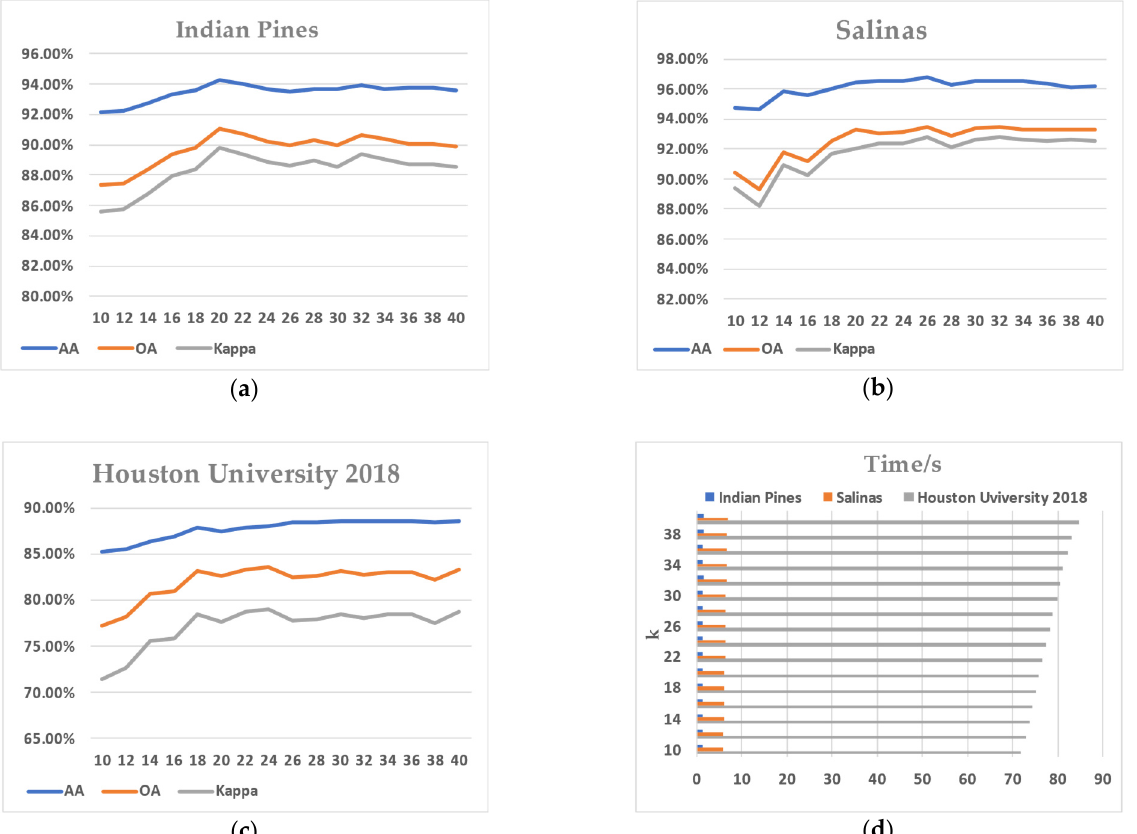
Figure 9. Sensitivity analysis of parameter k in the second stage. k ranges from 10 to 40 with step 2 and the classification results in ( a ) Indian Pines; ( b ) Salinas; ( c ) Houston University 2018, and ( d ) computing time in corresponding datasets.